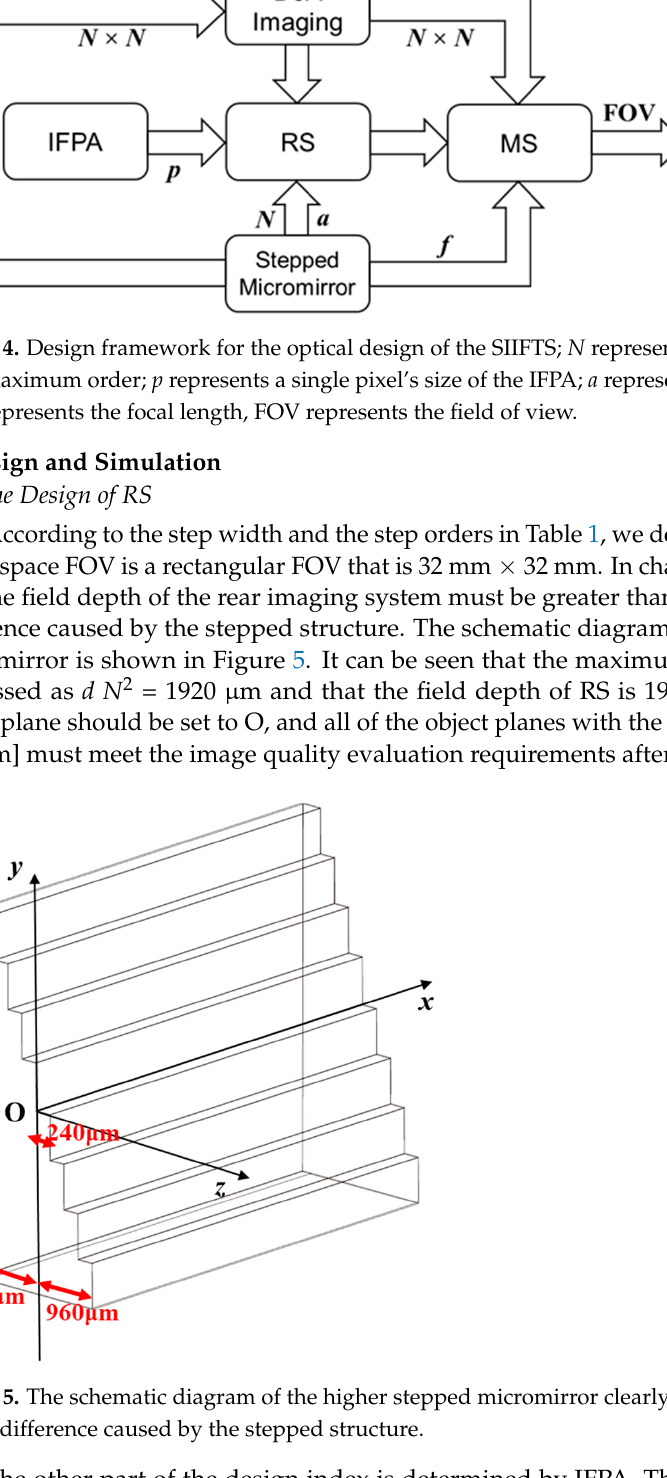
Figure 5. The schematic diagram of the higher stepped micromirror clearly expresses the maximum height difference caused by the stepped structure.